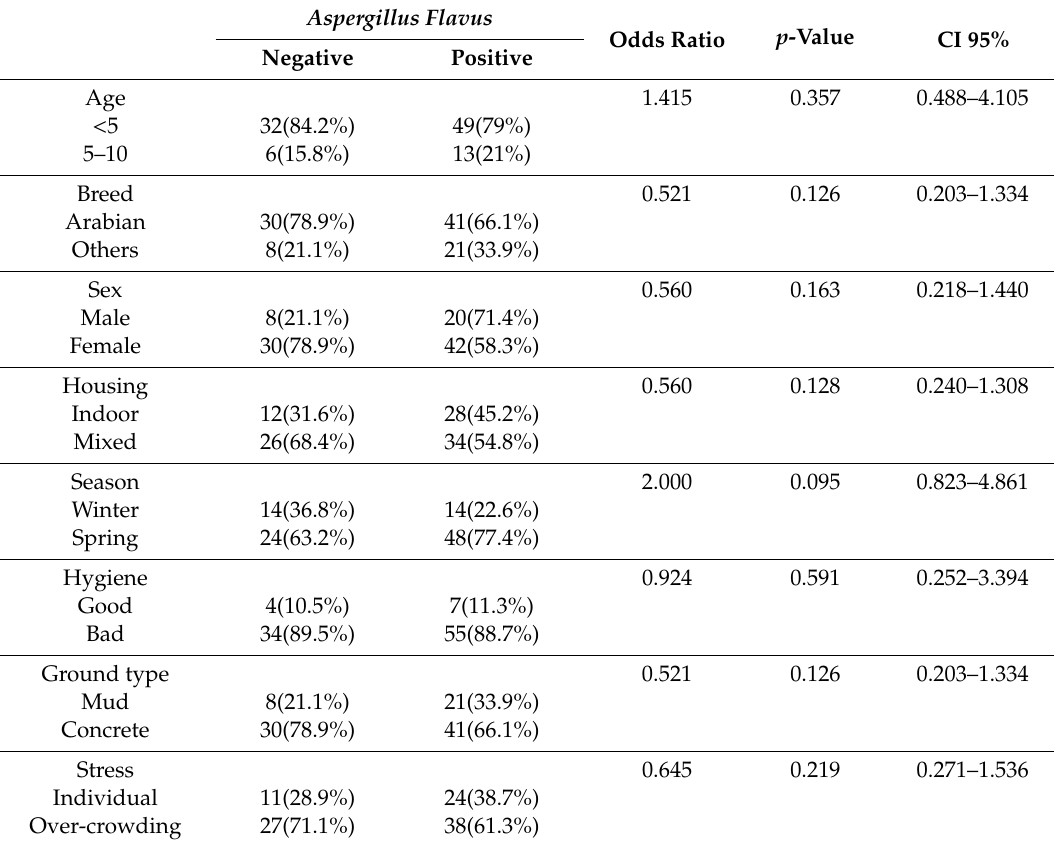
Table 3. Risk factors of Aspergillus flavus